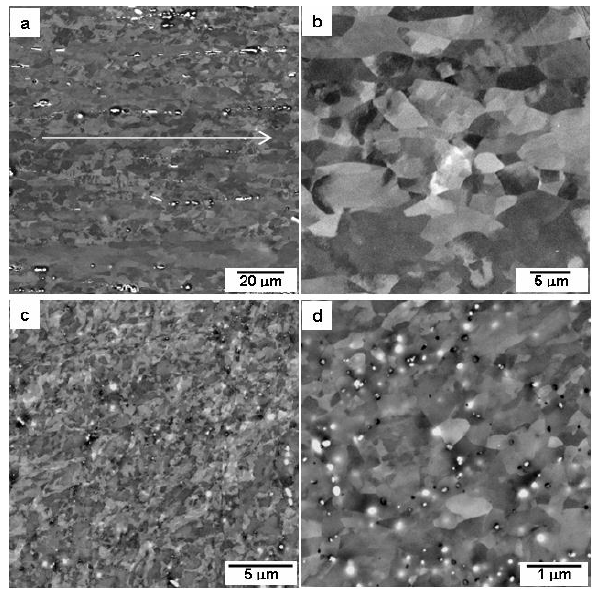
Figure 2. Backscattered electron micrographs of the microstructure of the Al 6101 alloy wire rod: ( a , b ) initial state (Т1); and ( c , d ) after ECAP-С (an arrow indicated the strain